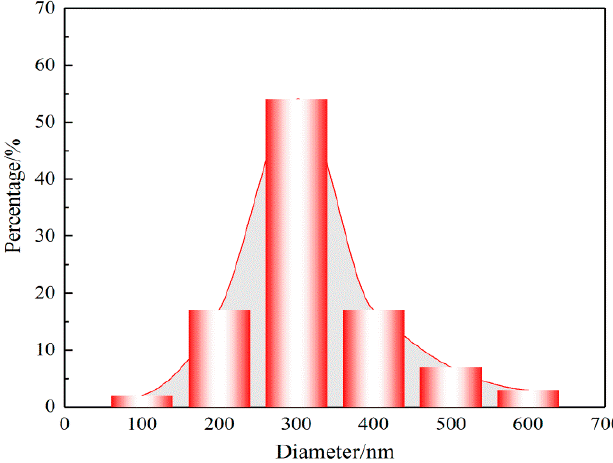
Figure 6. Diameter distribution of SF/PCL nanofibers.